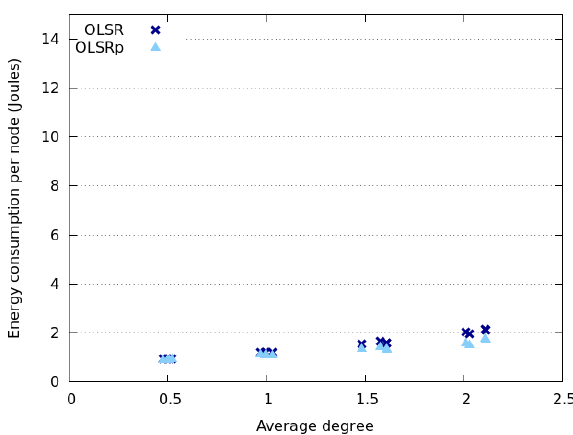
Figure 13. Energy consumption versus network degree when nodes follow a Random Walk